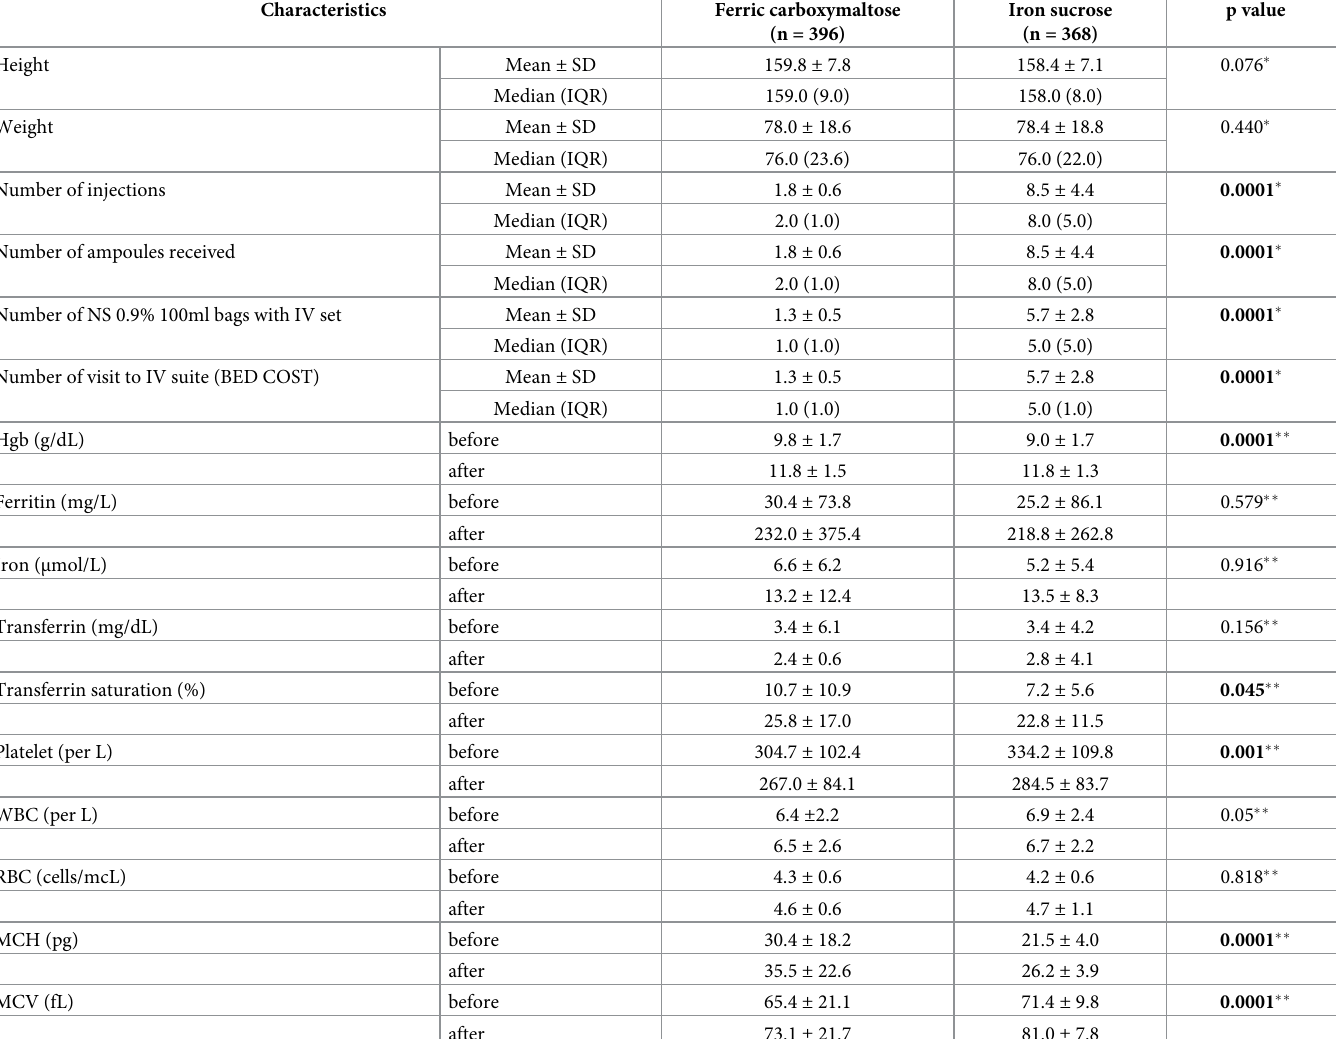
Table 2. Clinical characteristics and treatment outcomes for patients in the two treatment arms.